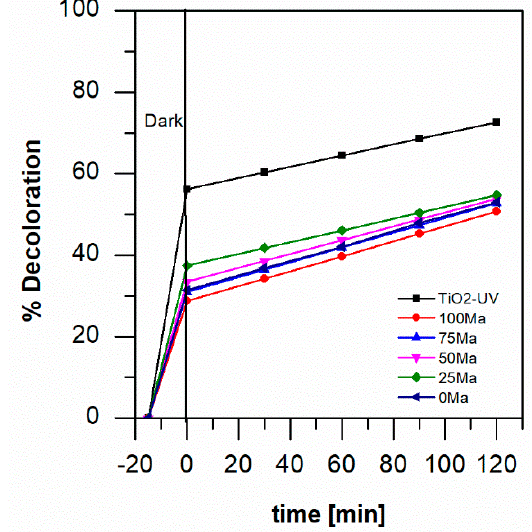
Figure4. Percentageofdegradationbyphotocatalysisof1mMofanilineblueatpH3withTiO 2 -foam / UV Figure 4. Percentage of degradation by photocatalysis of 1 mM of aniline blue at pH 3 with TiO 2 - light and with TiO 2 -anthocyanin-foam / visible light. foam/UV light and with TiO 2 -anthocyanin-foam/visible light.